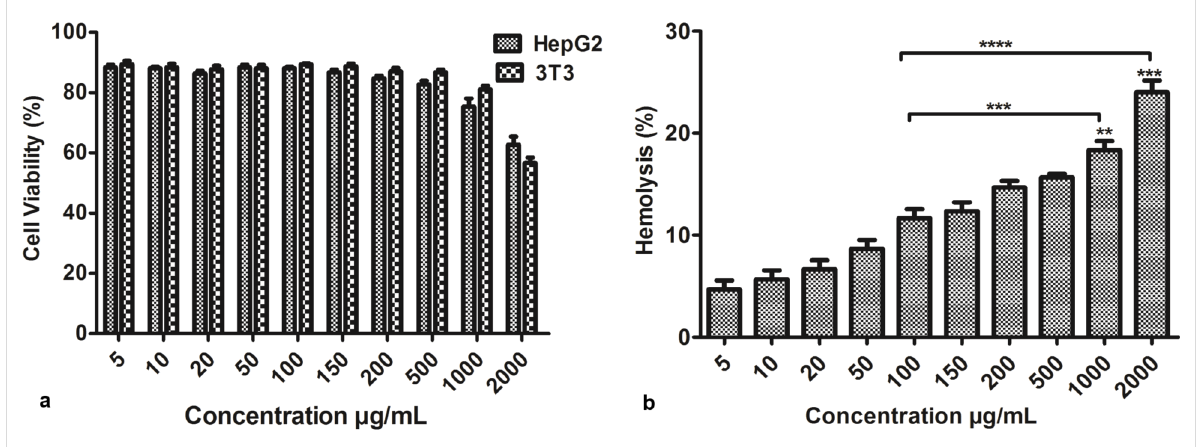
Figure 4: (a) Relative viabilities of HepG2 and 3T3 cells after being incubated with different concentrations of PSS-GNRs for 24 h. (b) A hemotoxicity assay on PSS-GNRs shows that PSS-GNRs are hemo-compatible. No significant difference was seen in the range of 5–500 µg/mL (<20% hemolysis). A low significant (***) of a high significant difference (****) were seen for 1000 and 2000 µg/mL compared with 100 µg/mL. Each bar shows the mean value ± SEM of